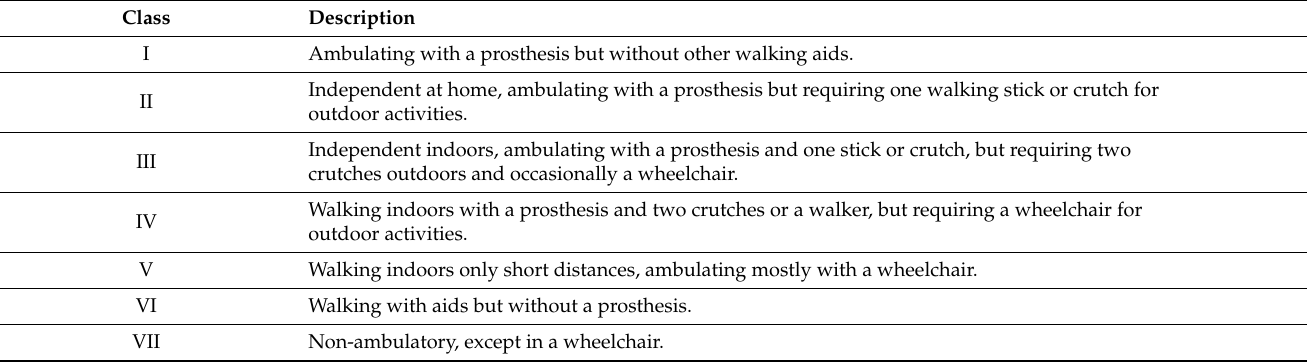
Table A1. Pohjolainen